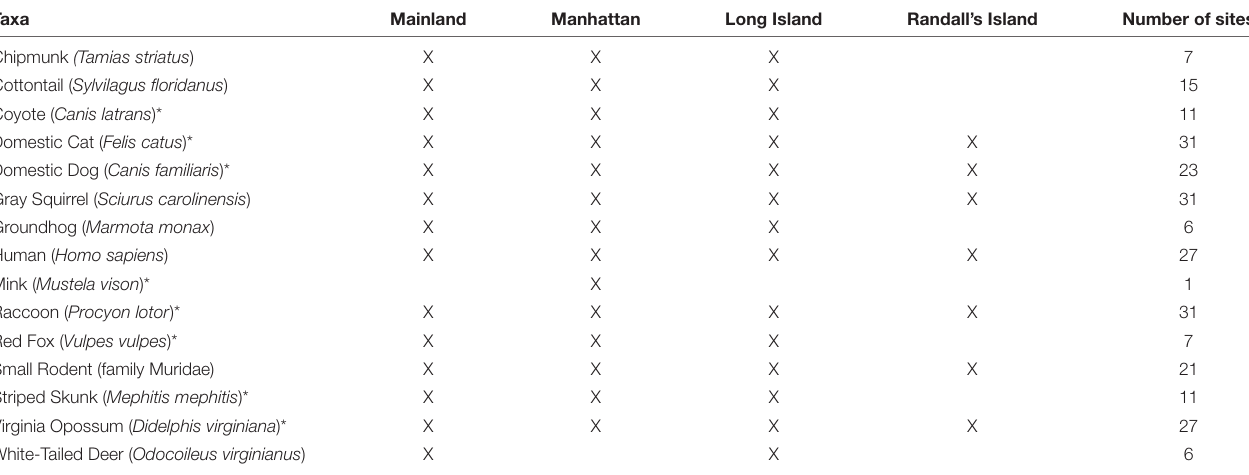
TABLE 3 | Mammal taxa identified across the 31 study sites by region and number of